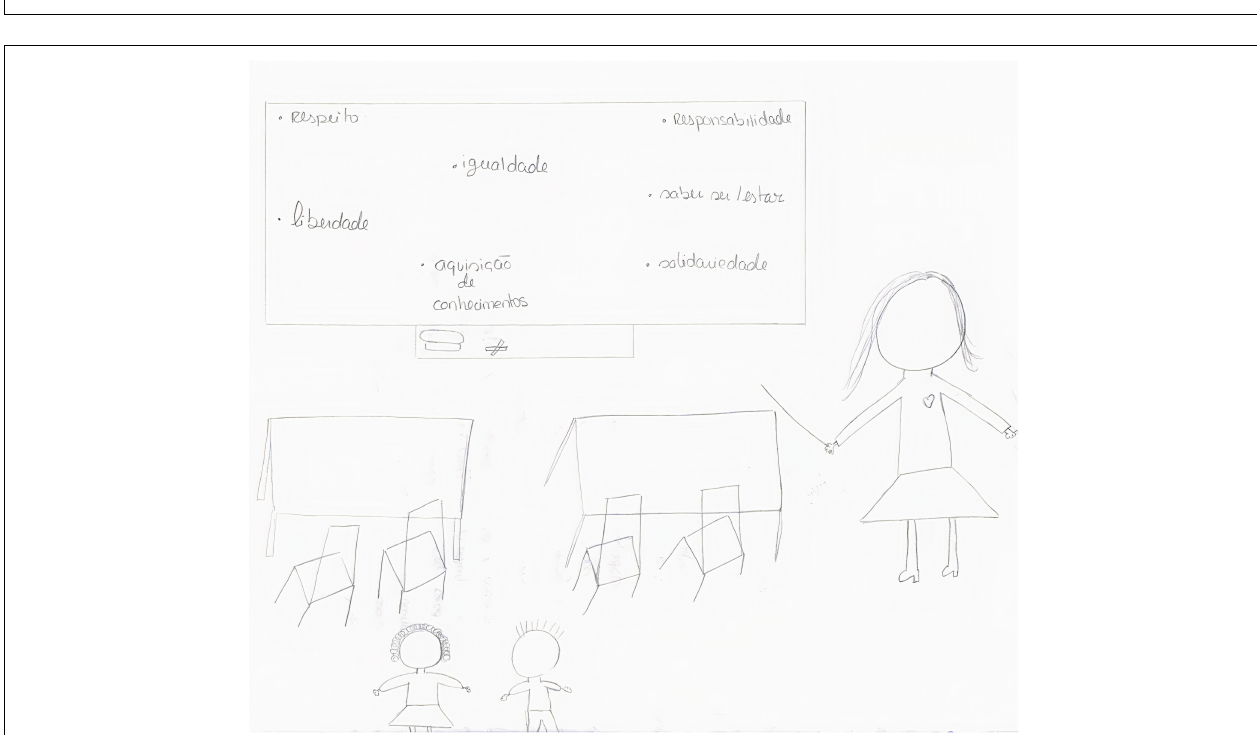
FIGURE 2 | “Me as a GCE teacher”: Irina’s